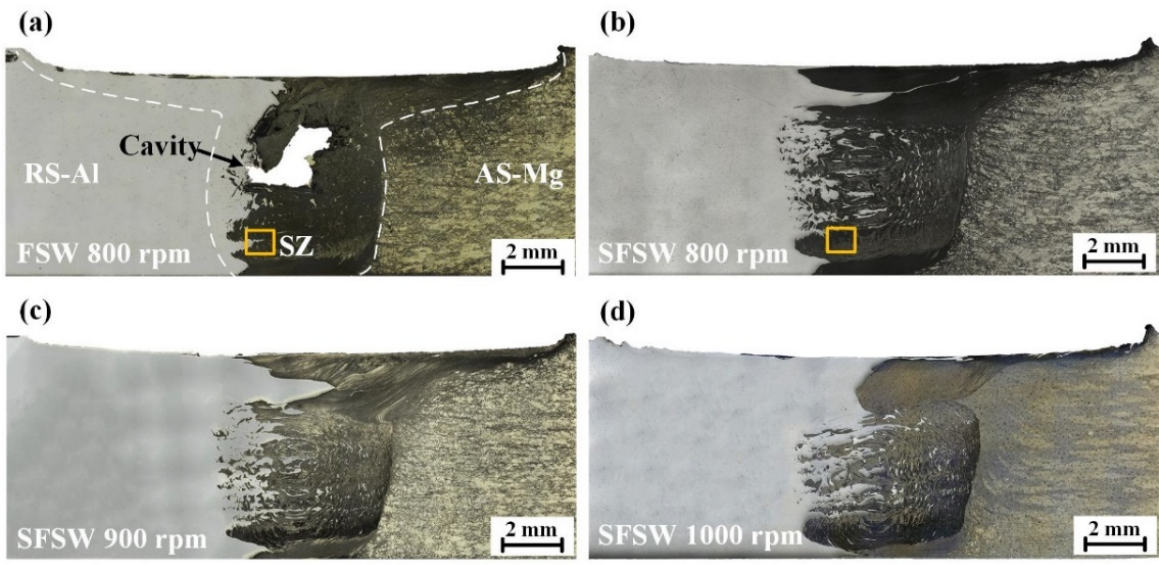
Figure 4. Cross-section macrographs of the joints produced by ( a ) FSW at 800 rpm, ( b – d ) SFSW at 800 rpm, 900 rpm, and 1000 rpm.